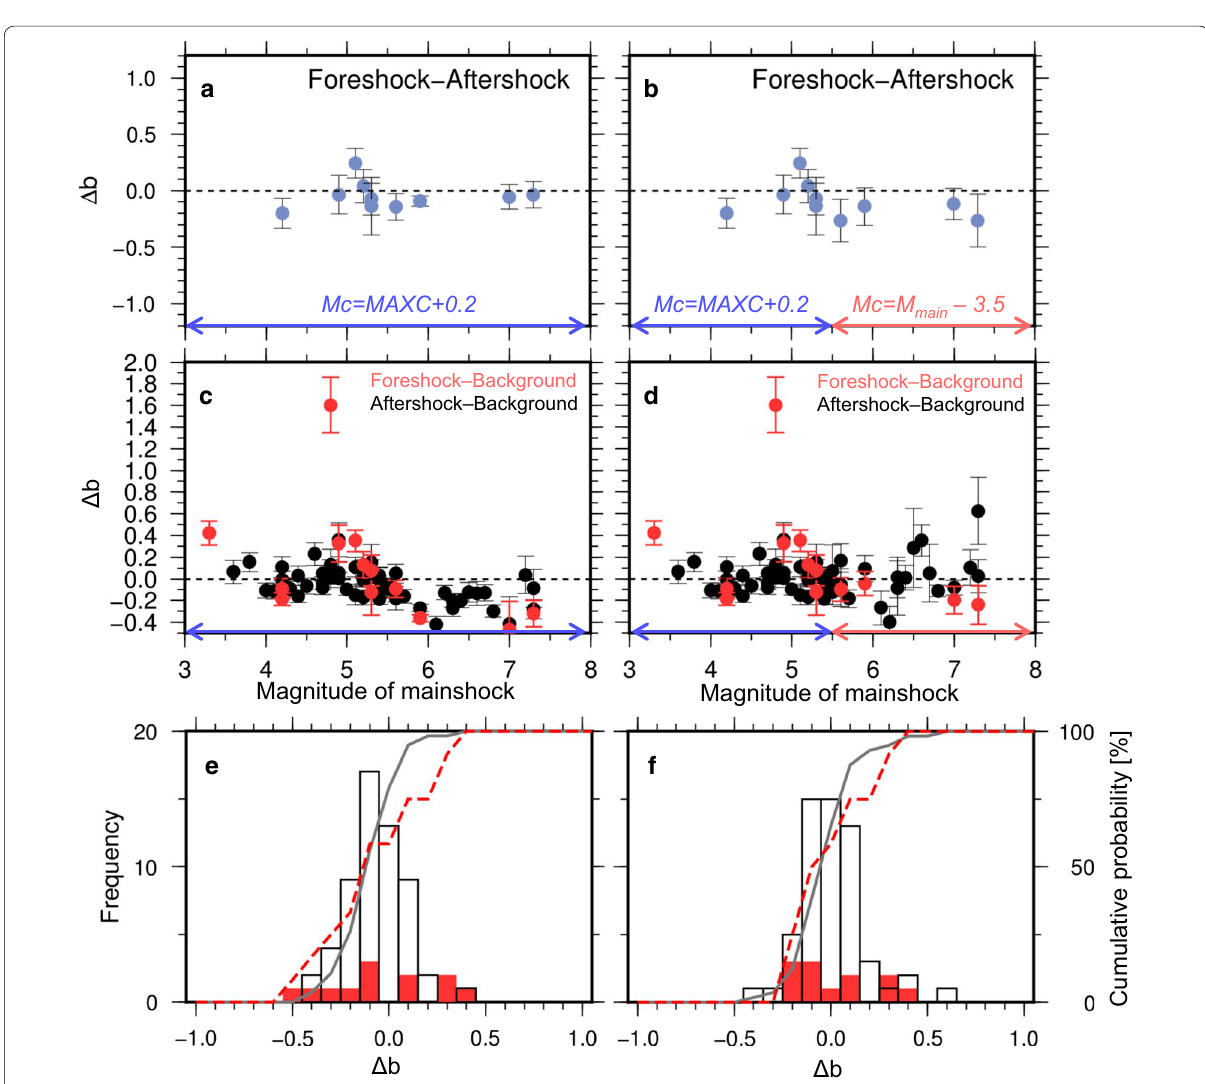
Fig. 5 Comparison of b -value differences. a – d Comparison of the magnitude of the mainshock and b -value differences. The magnitude of the mainshock is shown on the horizontal axis; the vertical axis shows the b -value difference. a , b Foreshocks–aftershocks (with 200 foreshocks and 200 aftershocks), c , d foreshocks—background (with 200 foreshocks, red circle), and aftershocks–background (with 200 aftershocks, black circle). e , f His- togram of b -value differences. The frequency of the b -value differences is on the left axis, and the cumulative probability is shown on the right axis. a , c , e Mc was chosen as MAXC 0.2 for the entire magnitude range, b , d , f Mc was chosen as MAXC + The b -value of the background was calculated using hypocenters other than the target cluster within the range